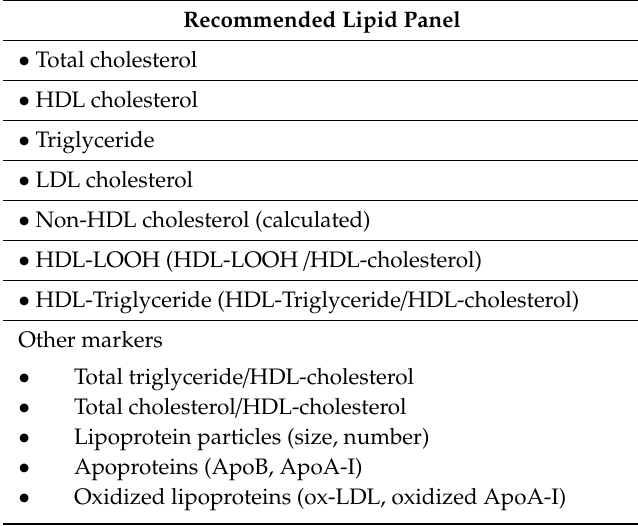
Table 1. A new lipid panel for the assessment of lipoprotein-related atherosclerotic cardiovascular disease.